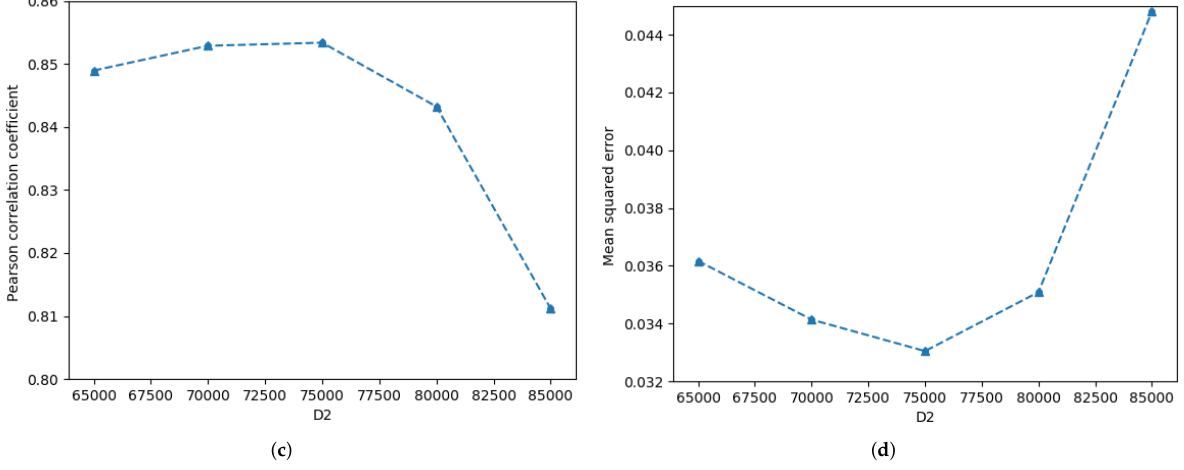
Figure 6. Detailed influence of the D 1 and D 2 on semantics of STS’15.headlines.txt. ( a ) Pearson correlation coefficient- D 1 , ( b ) Mean squred error- D 1 , ( c ) Pearson correlation coefficient- D 2 , ( d ) Mean squred error- D 2